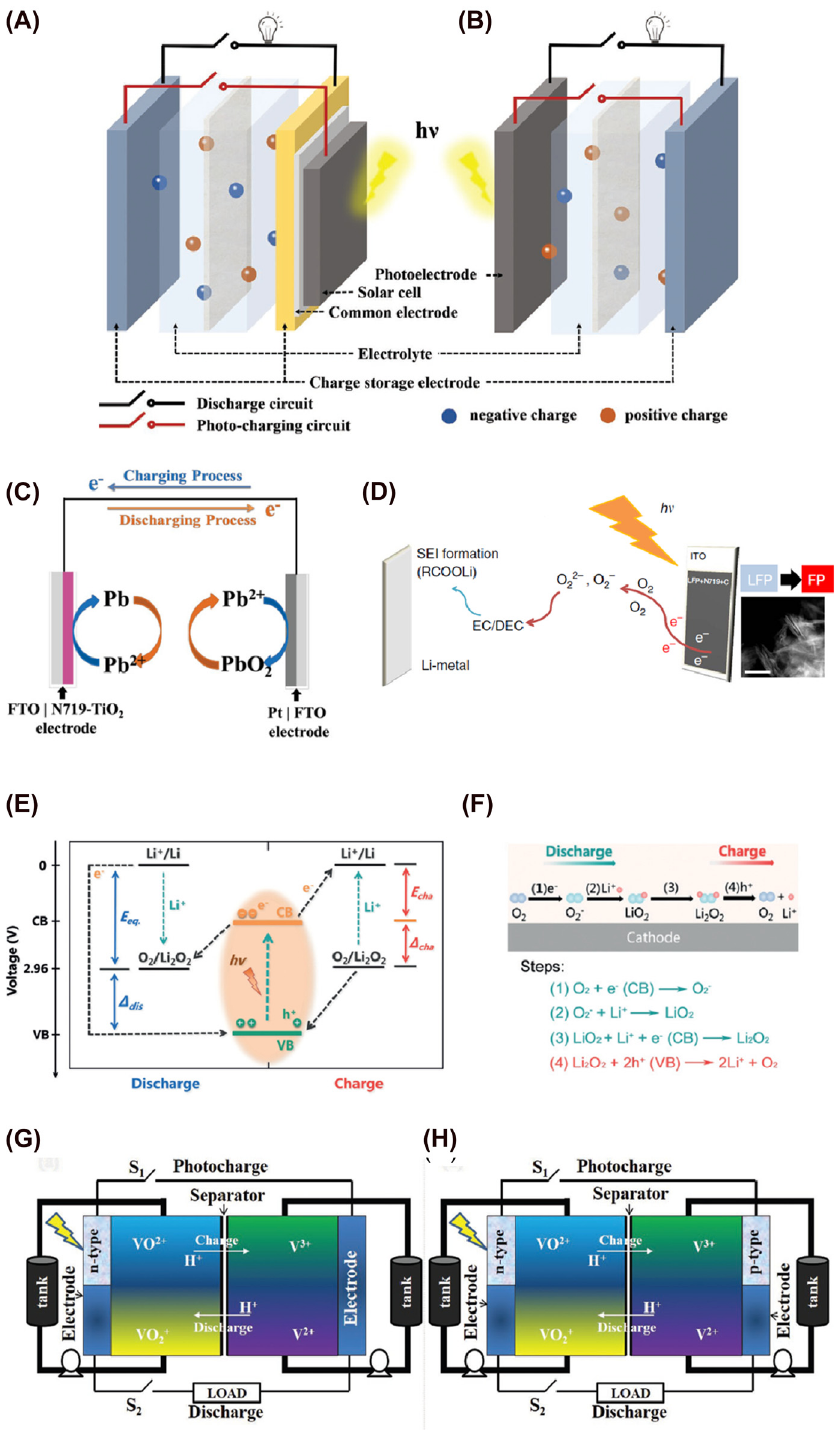
Figure 2: Battery configuration of integrated (A) three-electrode PBAT, (B) two-electrode PBAT [51]. Copyright 2020, John Wiley and Sons; (C) Redox reactions at the electrodes under charging and discharging processes [82]. Copyright 2015, John Wiley and Sons; (D) Global photo- assisted charging mechanism of Li-ion PABT [83]. Copyright 2017, Springer Nature; (E) Energy diagrams for the discharge and charge voltage under illumination; (F) reactions in discharge and charge processes [84]. Copyright 2019, John Wiley and Sons; SFB with (G) single photo- electrode (H) dual photoelectrodes [44]. Copyright 2018, John Wiley and